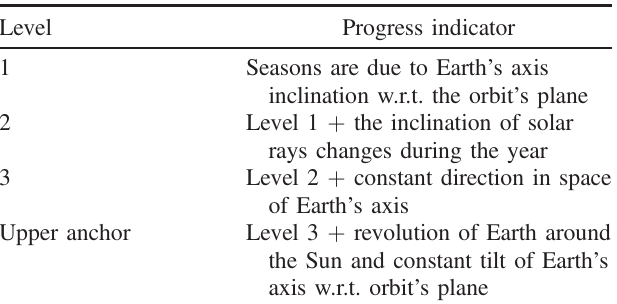
TABLE V. Modified learning progression about change of